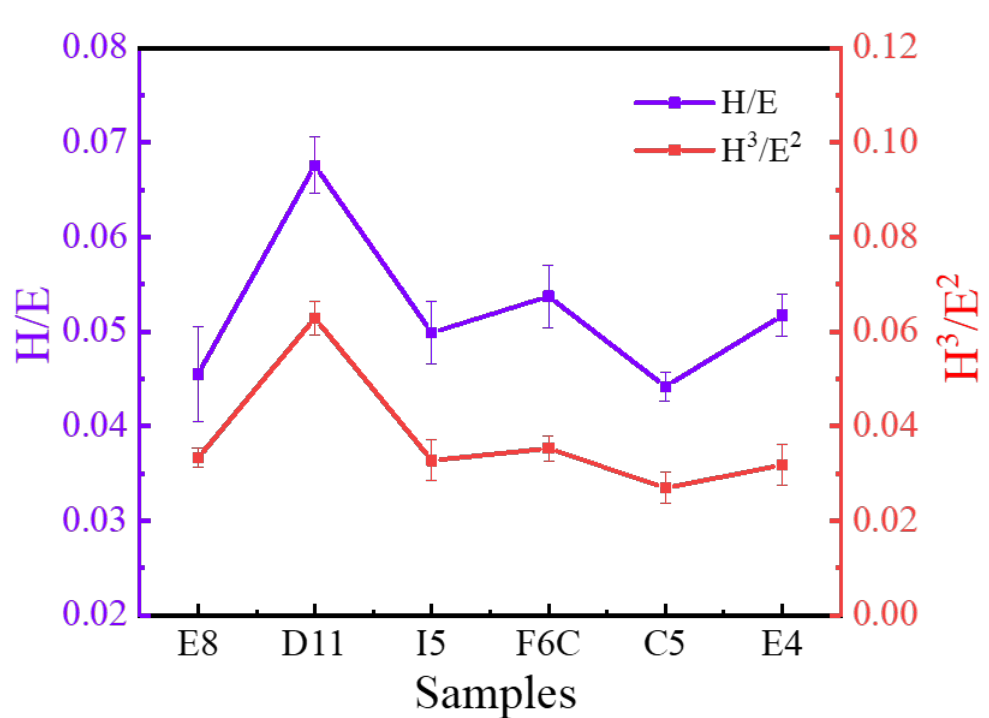
Figure 11. Elastic strain to failure, H/Er, and resistance to plastic deformation, H 3 /E 2 , of ZrMoTaW RMPEA thin films.